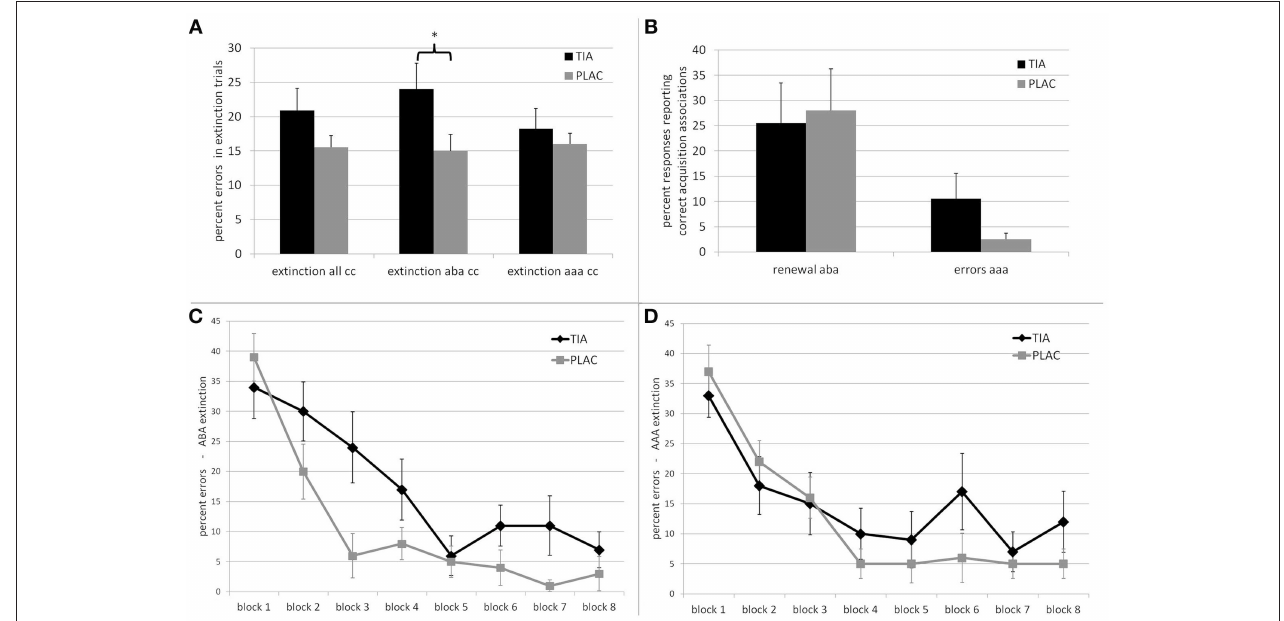
FIGURE 2 | Top: Behavioral performance of the TIA (black) and PLAC (gray) groups. (A) Percentage of errors in extinction learning for trials with a consequence change (cc), for all trials, ABA, and AAA trials. * The difference is significant at p < 0 . 05 . (B) Percentage of responses in extinction recall that report associations correct during acquisition, that is responses which constitute renewal responses in ABA trials and errors in AAA trials. Bottom: Learning curve for (C) ABA extinction and (D) AAA extinction. Error bars denote standard